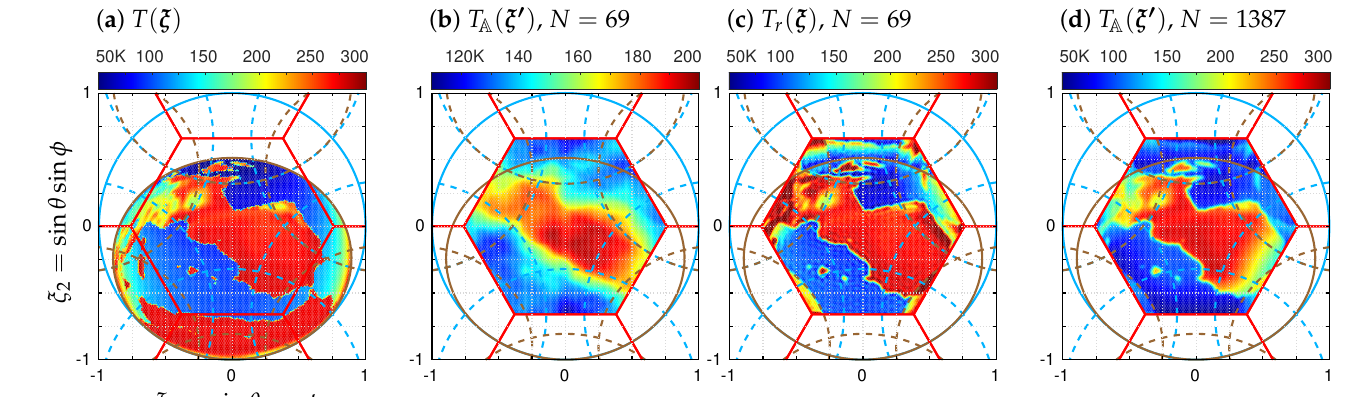
Figure 14. Comparison between ( a ) a typical scene over Spain in X polarization at a resolution better than 0.01 rad, ( b ) the corresponding antenna temperature map simulated for the Y-shaped array of SMOS using DBF with 69 elementary antennas at the resolution of 0.0355 rad, ( c ) the brightness temperature distribution retrieved from the inversion of ( b ) at the resolution of 0.0278 rad, and ( d ) an- other antenna temperature map simulated for an hexagonal array using DBF with 1387 elementary antennas at the resolution of 0.0299 rad. The same behavior is observed in Y